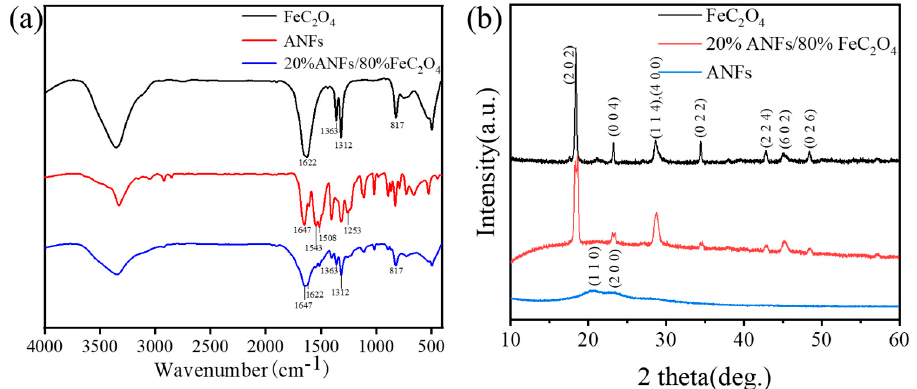
Figure 5. ( a ) FTIR spectra of FeC 2 O 4 , ANFs, and ANFs/FeC 2 O 4 . ( b ) XRD spectra of FeC 2 O 4 , ANFs, and ANFs-FeC 2 O 4 .